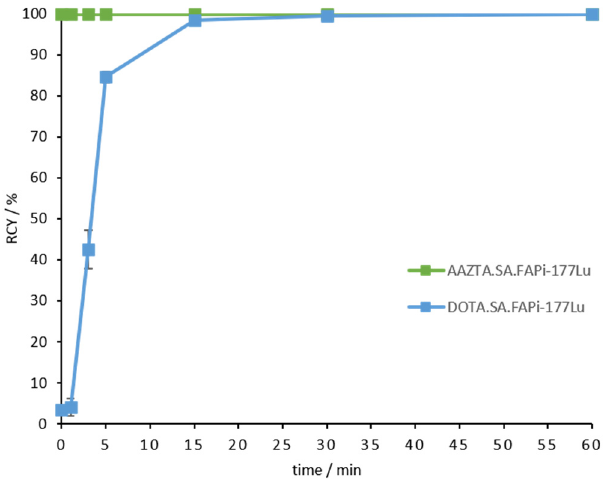
Figure 6. Kinetic measurements for [ 177 Lu]Lu-AAZTA 5 .SA.FAPi up to 60 min (green); Kinetic measurements for [ 177 Lu]Lu-DOTA.SA.FAPi up to 60 min (blue); ( n = 3, 20 nmol for both conjugates).